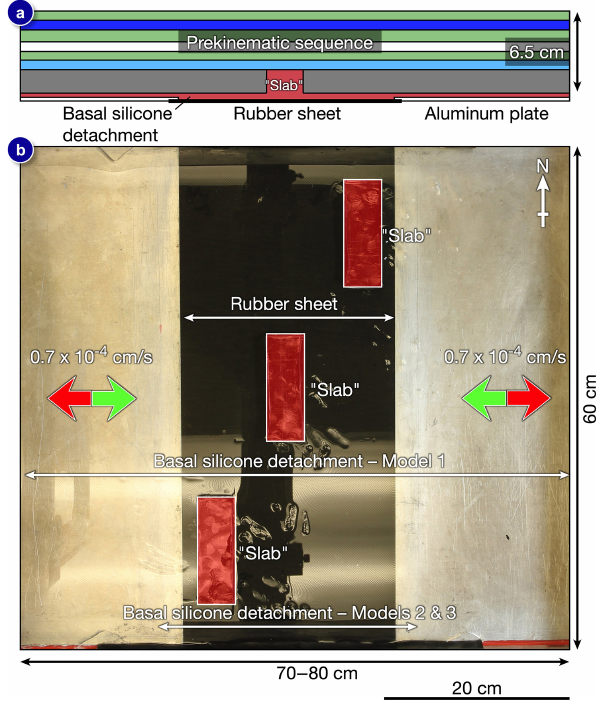
Figure 2. Summary of experimental setup used in models shown in this study. (a) Cross-section view of the pre-rift setup. Models con- sist of a stretching rubber sheet overlain by a thin basal detachment and polymer slabs covered by a layered sand pack. (b) Overhead view of deformation rig prior to emplacement of the layered pre-rift overburden. See text for further